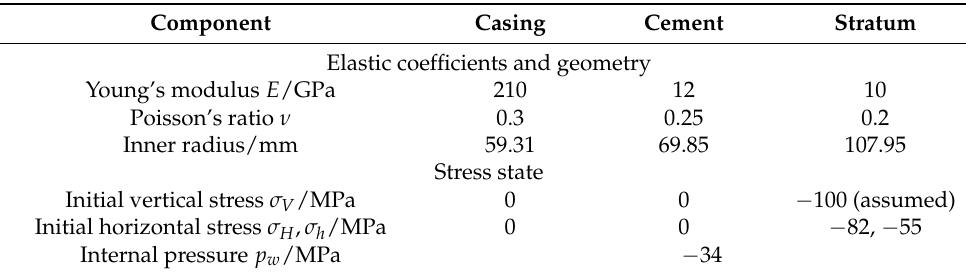
Table 1. Input parameters (Data from Liu et al.